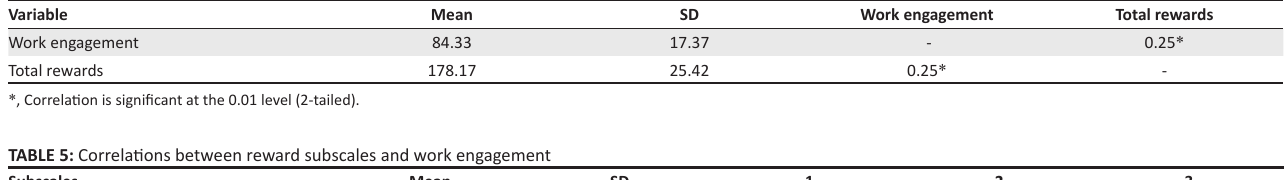
TABLE 4: Correlations between total rewards and work engagement. Variable